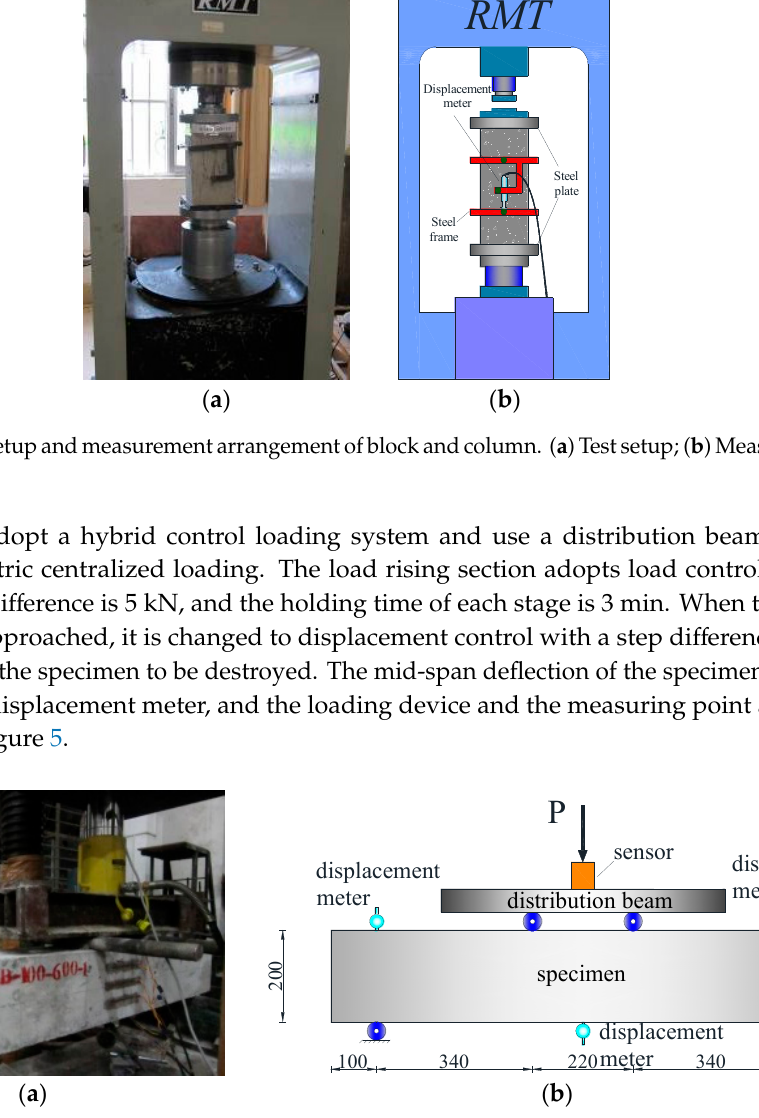
Figure 5. Test setup and measurement arrangement of beam. ( a ) Test setup; ( b ) Measurement arrangement.